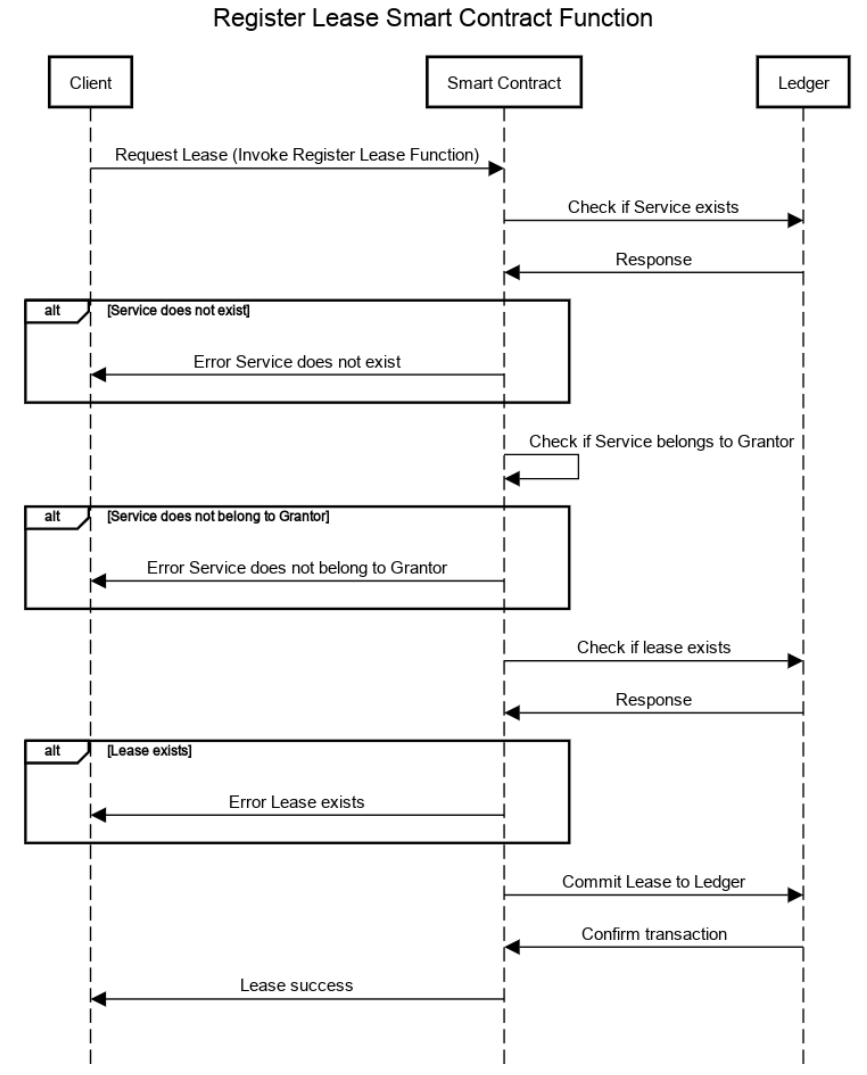
Figure 2. Register Lease Smart Contract